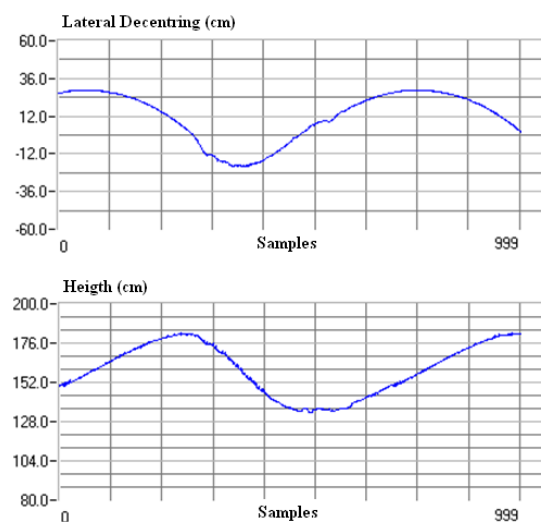
Figure 8. Contact wire measurements at a sample speed of 100 fps: Height and lateral